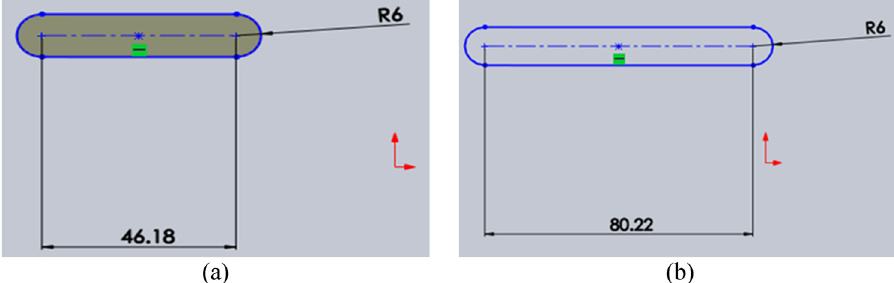
Figure 3: Sketch of links ( a ) r 2 and ( b ) r 4 .